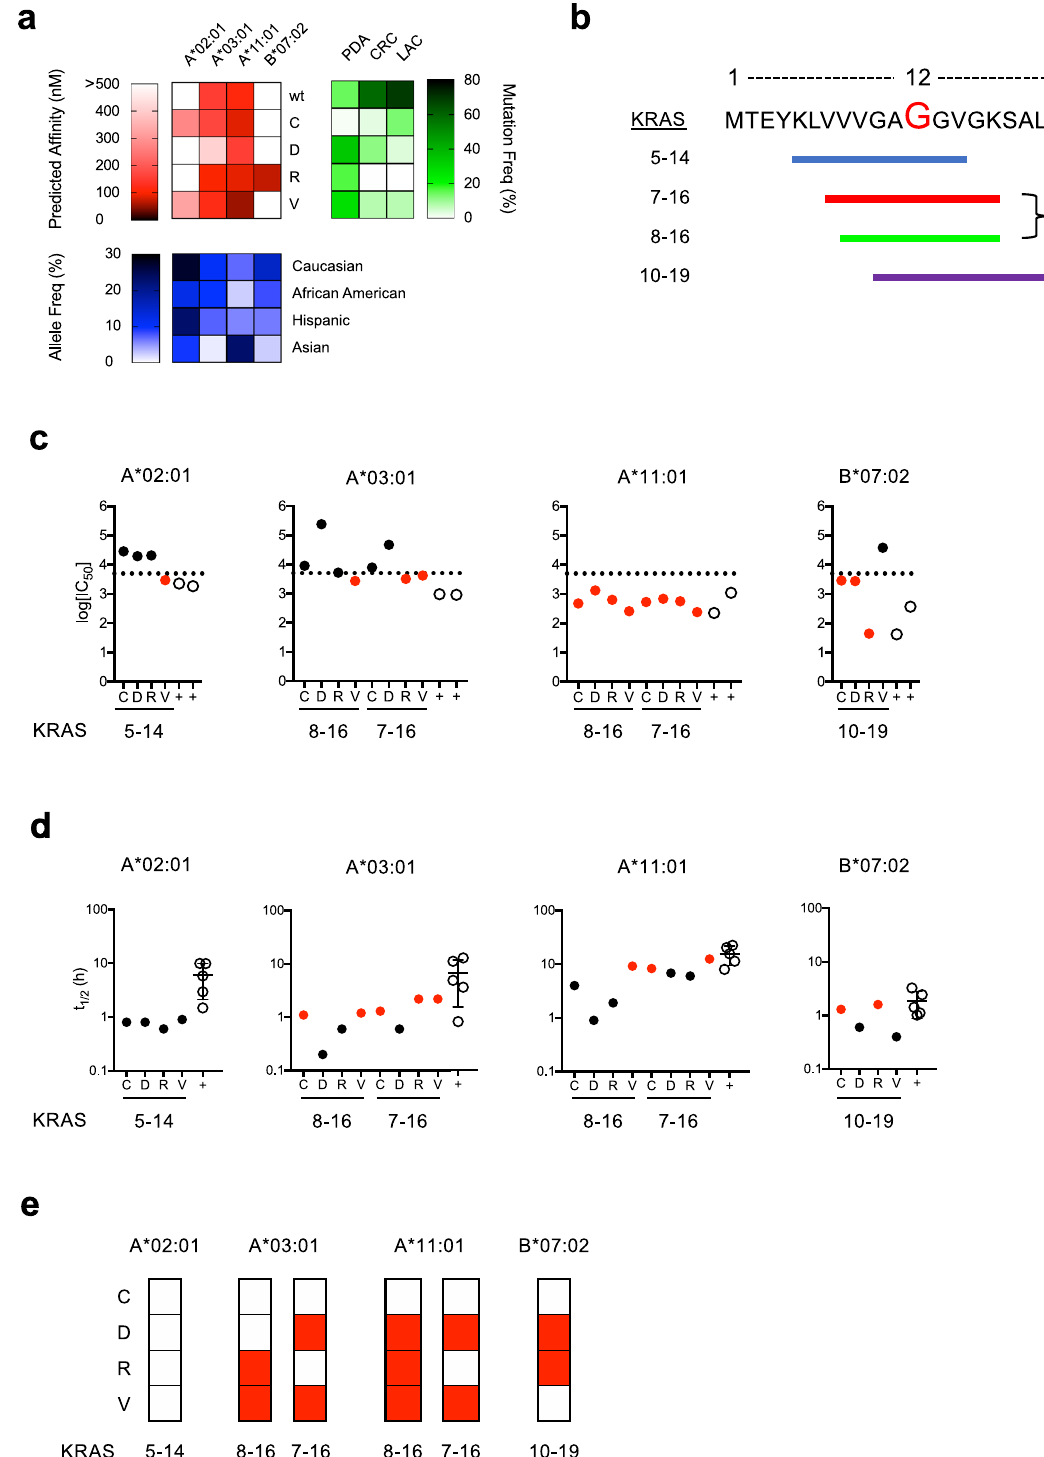
10-mer peptides formed more stable p-HLA-A * 11:01 complexes compared to 9-mer peptides ( t 1/2 6 – 12 h vs 0.9 – 9.2 h) (Fig. 1d). For HLA-B * 07:02 epitopes, peptides 10-19C, 10-19D, and 10-19R bound with high af fi nity (log 10 [IC 50 ] ≤ 3.460 nM) (Fig. 1c), but only 10-19C and 10-19R exhibited p-HLA complex stability equivalent to positive control peptides ( t 1/2 > 1 h) (Fig. 1d). A comparison of predicted and experimentally determined p-HLA af fi nities showed a strong correlation for 8-16C-V and 7-16C-V peptides restricted by